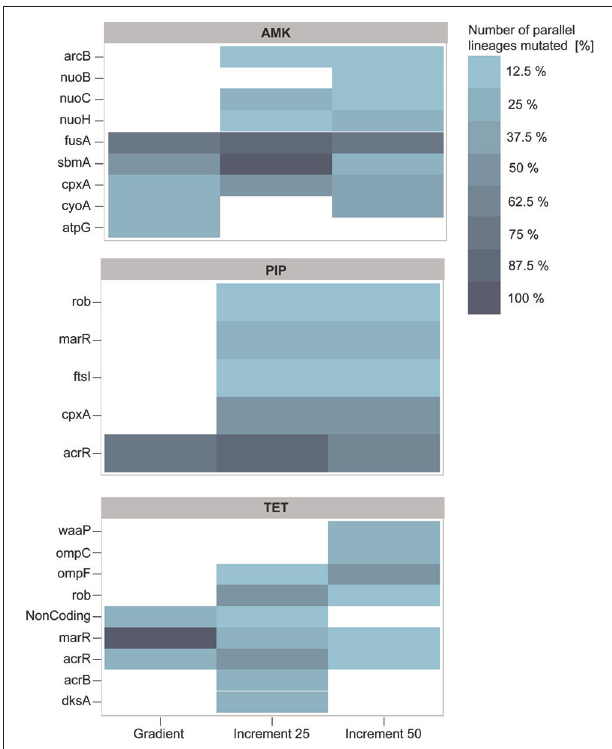
FIGURE 5 | Genetic adaptations to the antibiotics amikacin (AMK), piperacillin (PIP), and tetracycline (TET). The color represents the number of strains in percent that harbor a mutation, identified in at least two independent lineages. Almost all mutations identified in the gradient approach are also present in at least one of the increment strains. PIP and TET evolved lineages display similar genotypes with mutations predominantly affecting the mar